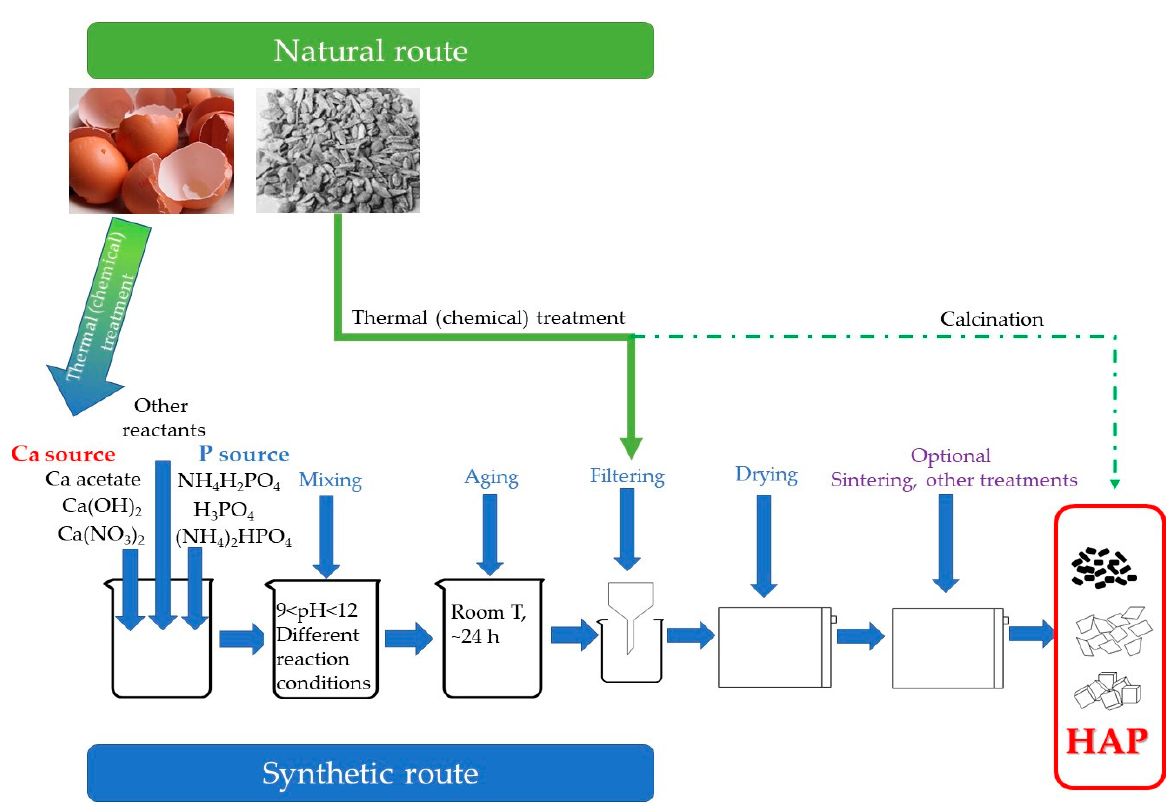
Figure 1. Development of hydroxyapatite-based adsorbents using natural and synthetic route. Schematic presentation.